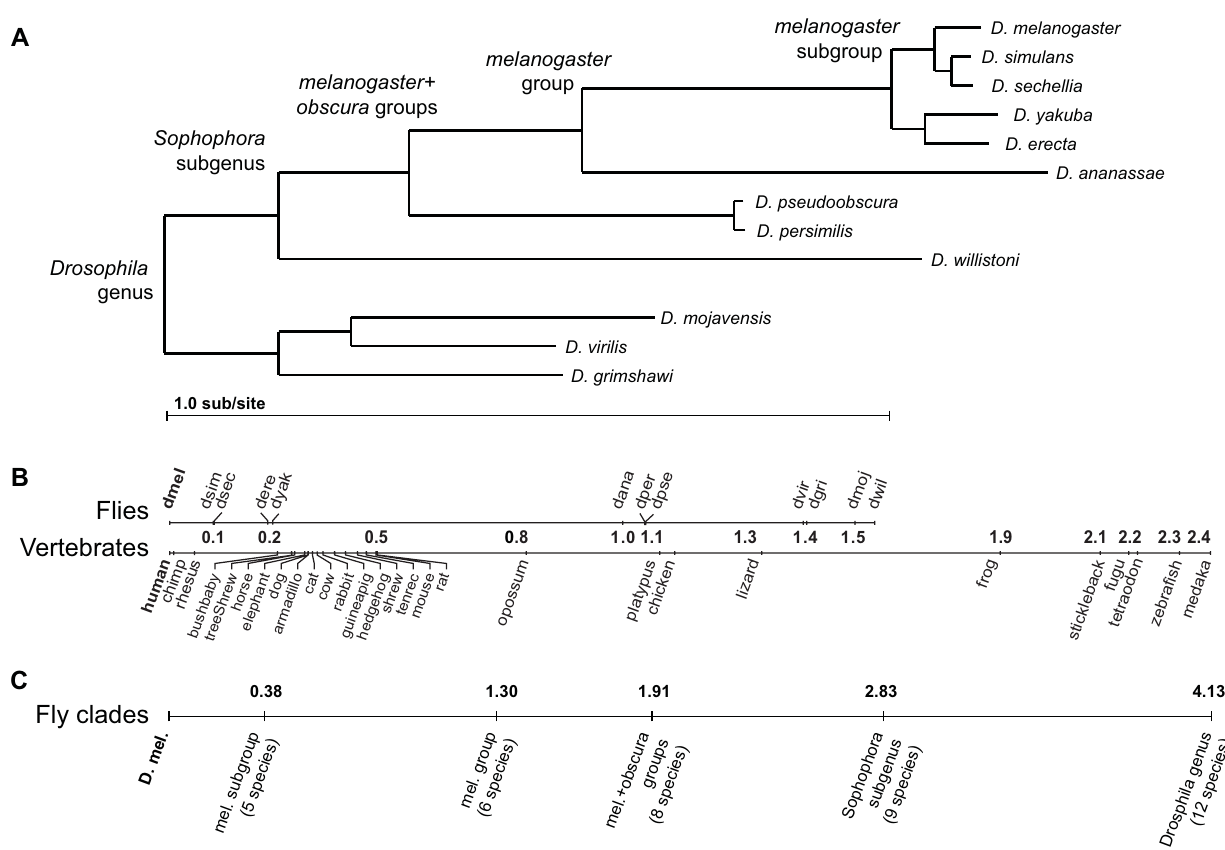
Figure 3. Evolutionary distances relating 12 Drosophila species. (A) Phylogenetic tree and estimated neutral branch lengths for the species. Tree topology follows the accepted phylogeny of these species [21,22]. Neutral substitution rates estimated from 12,861 4-fold degenerate sites in syntenic one-to-one orthologs (see Methods). (B) Pairwise distance of each of the 11 other Drosophila species from D. melanogaster , as compared to similarly estimated distances for vertebrates. (C) Total independent branch length provided by several subsets of the Drosophila species used to benchmark multi-species methods.